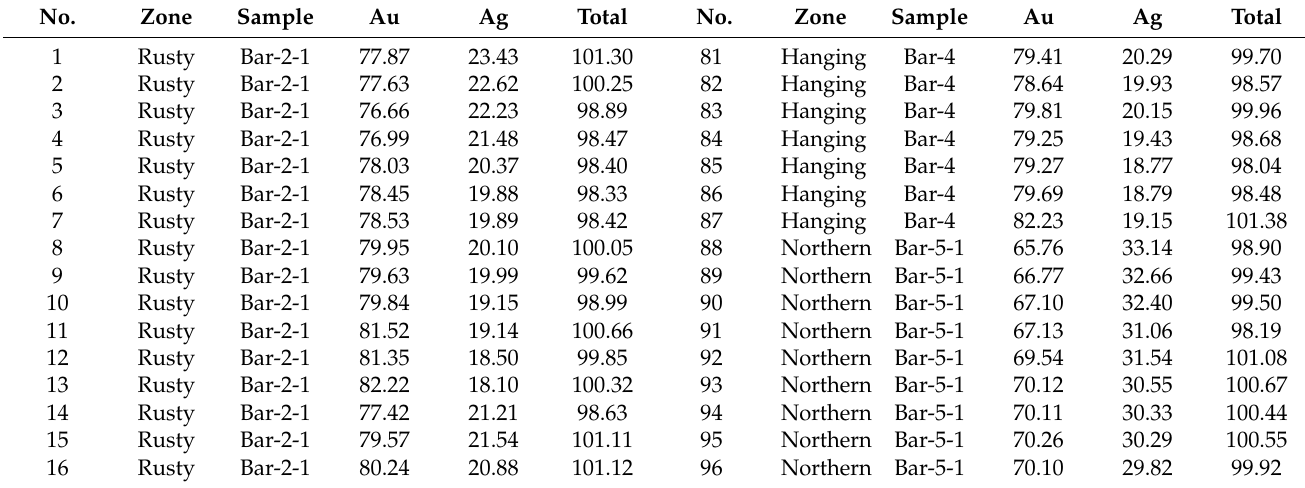
Figure 7. Variations in the composition of Au-Ag solid solutions from argillaceous- ocher sediments under mineralized outcrops of the Central and Southern zones.